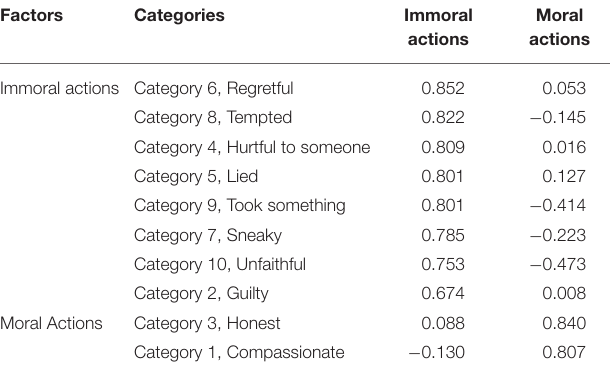
TABLE 5 | The underlying cognitive factors of the categories based on an exploratory factor